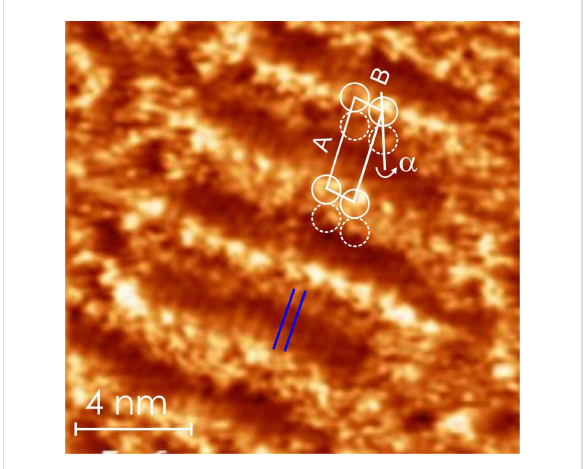
Figure 7: STM constant height image (1.2 V, 1 nA) of the linear pattern of the synthesized monoester at the HOPG–undecanol inter- face (A = 3.1 ± 0.1 nm; B = 1.0 ± 0.1 nm; α = 23 ± 1°). The triangular features indicated with circles correspond to the TMA head groups and blue lines indicate alkyl chains of synthesized monoester molecules. The orientation of the alkyl chain adopts an angle of ≈ 2° with respect to the A axis (indicated as β in other images). According to the calcula- tion it is expected that the alkyl chain of synthesized monoester should be almost parallel to the A